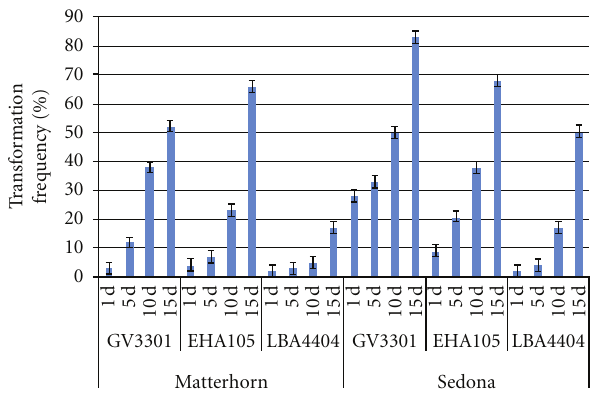
Figure 2: Percent transient expression of GUS at di ff erent number of days after bombardment.